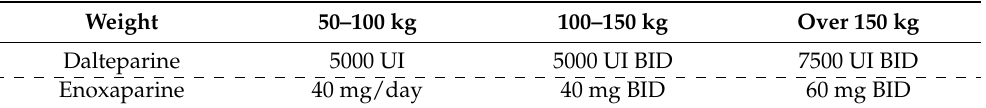
Table 1. LMWH dose adjustment based on body weight for perioperative DVT/PVT prophylaxis protocol in Ponderas Academic Hospital